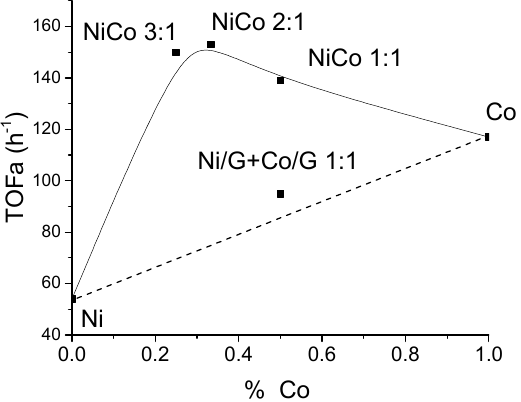
Figure 6. Evolution of the TOF conversion with the Co content in the catalysts.